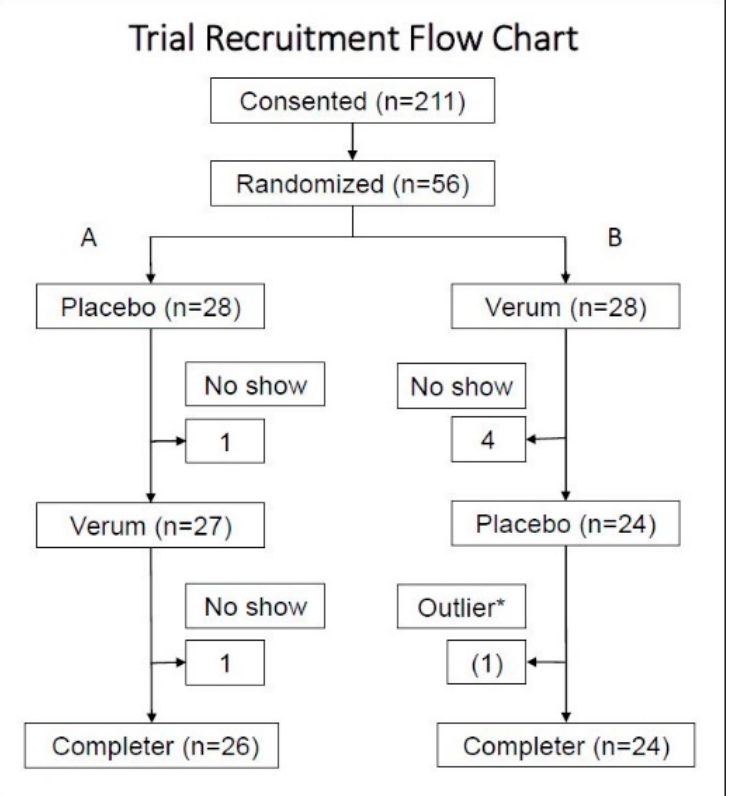
Figure 1. After screening and consenting, subjects were randomized to either Group A (placebo followed by verum) or Group B (verum followed by placebo). With the single crossover design, subjects who participated in both verum and placebo measurements were included in the analysis per protocol. * One hsCRP data point was detected as an outlier by the Grubb’s HSD at the alpha = 0.05. This subject reported a flu episode on the date when the outlier was detected. This subject was not excluded; however, for aggregate statistics, the data points (follow-up 2) of this subject were excluded in